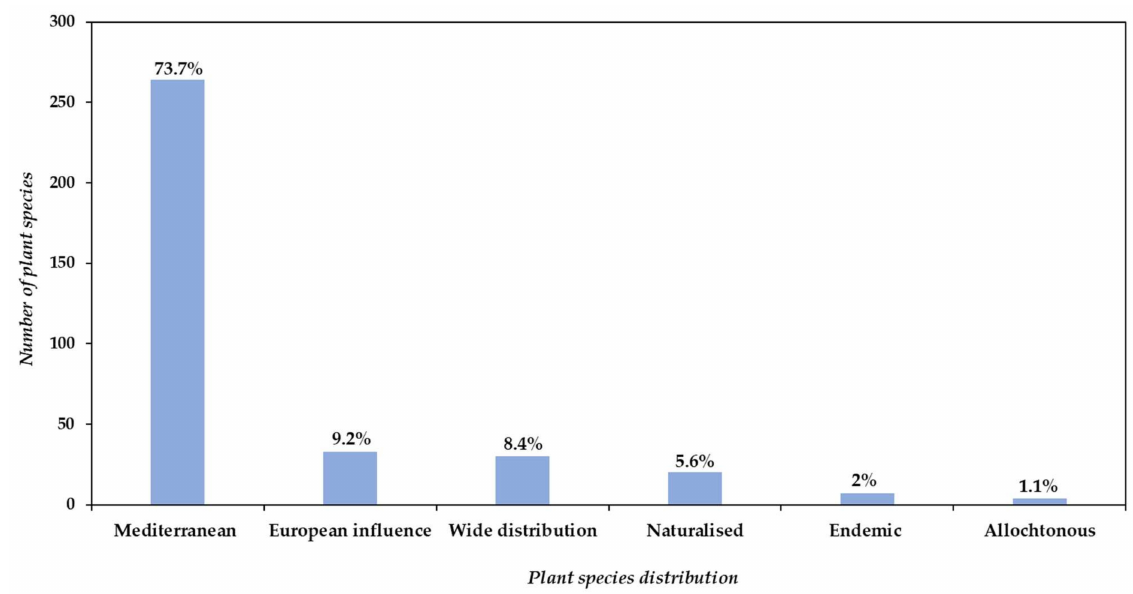
Figure 6. Chorological distribution of the flora recorded in the Southern Mediterranean forest rangelands of Northern